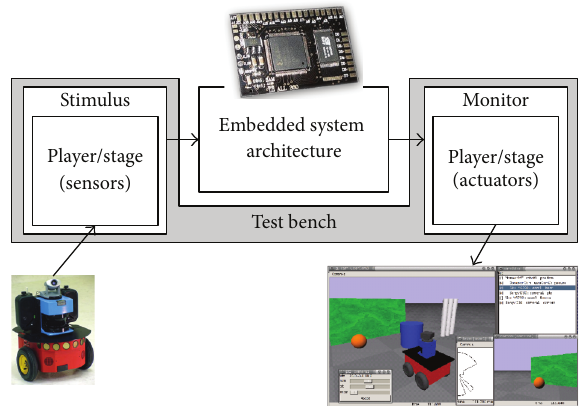
Figure 4: A hardware-in-the-loop simulation environment for embedded mobile robotics